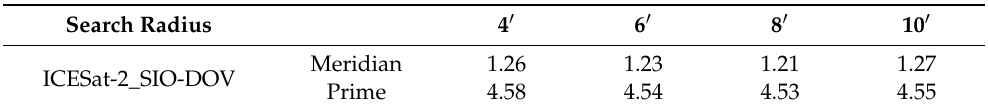
Table 9. STD of differences between gridded DOVs calculated by the along-beam DOVs with different search radii and the SIO V31.1_DOV model (Unit: arc_sec). Search Radius